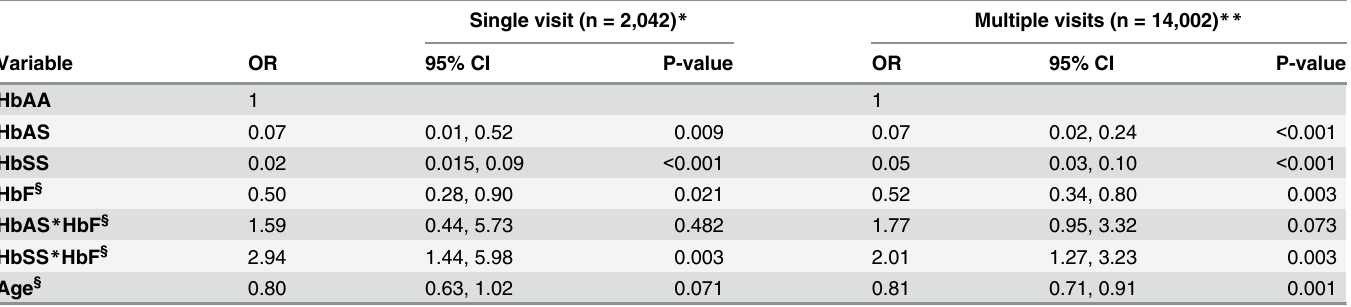
Table 2. Coefficient estimates from multivariate logistic (single visit at the time of HbF measurement) and GEE (multiple visits) regression models of malaria in relation to SCD status, HbF levels and age for individuals of all ages. Single visit (n = 2,042) * Multiple visits (n = 14,002) **